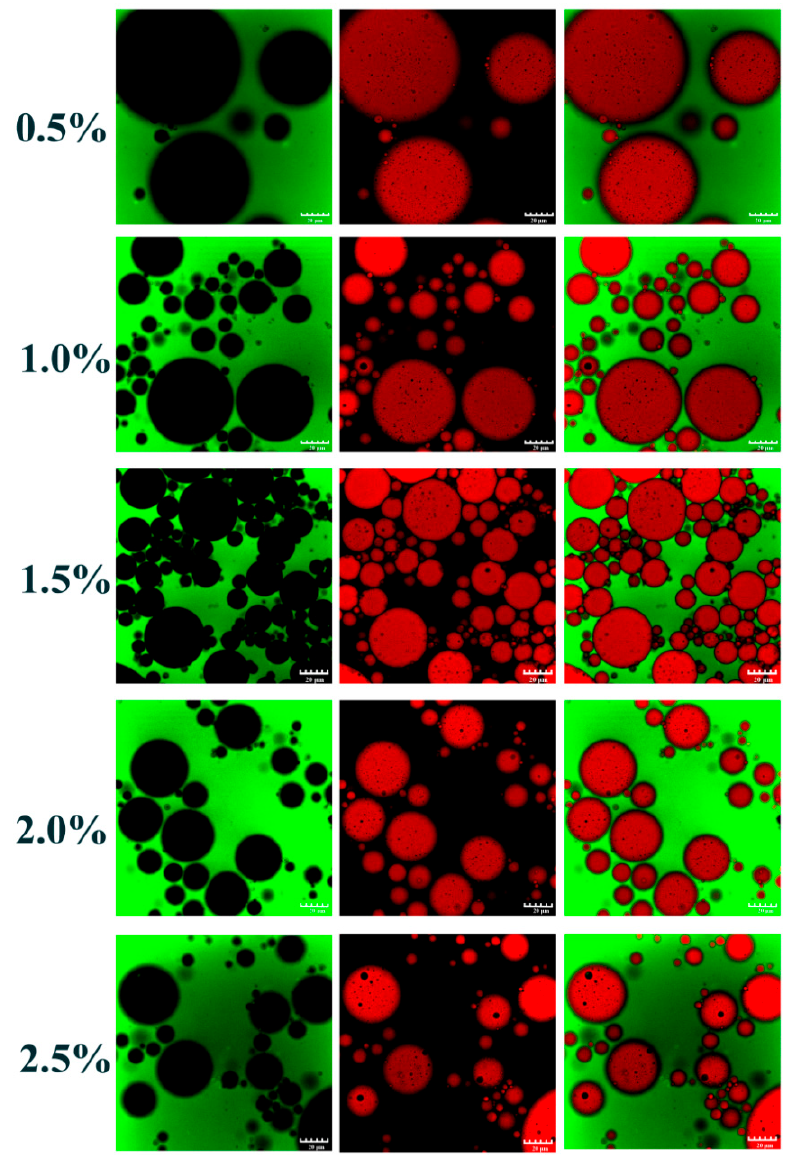
Figure 5. CLSM images (dilute the sample 10 times) of W 1 /O/W 2 emulgels (W 1 /O primary emulsion, 10%) stabilized by SSP concentrations were 0.5 wt%, 1.0 wt%, 1.5 wt%, 2.0 wt% and 2.5 wt%, respec- tively. The oil phase and outer aqueous phase were dyed with the Nile red and FITC, respectively. Scale bars, 50 μ m.